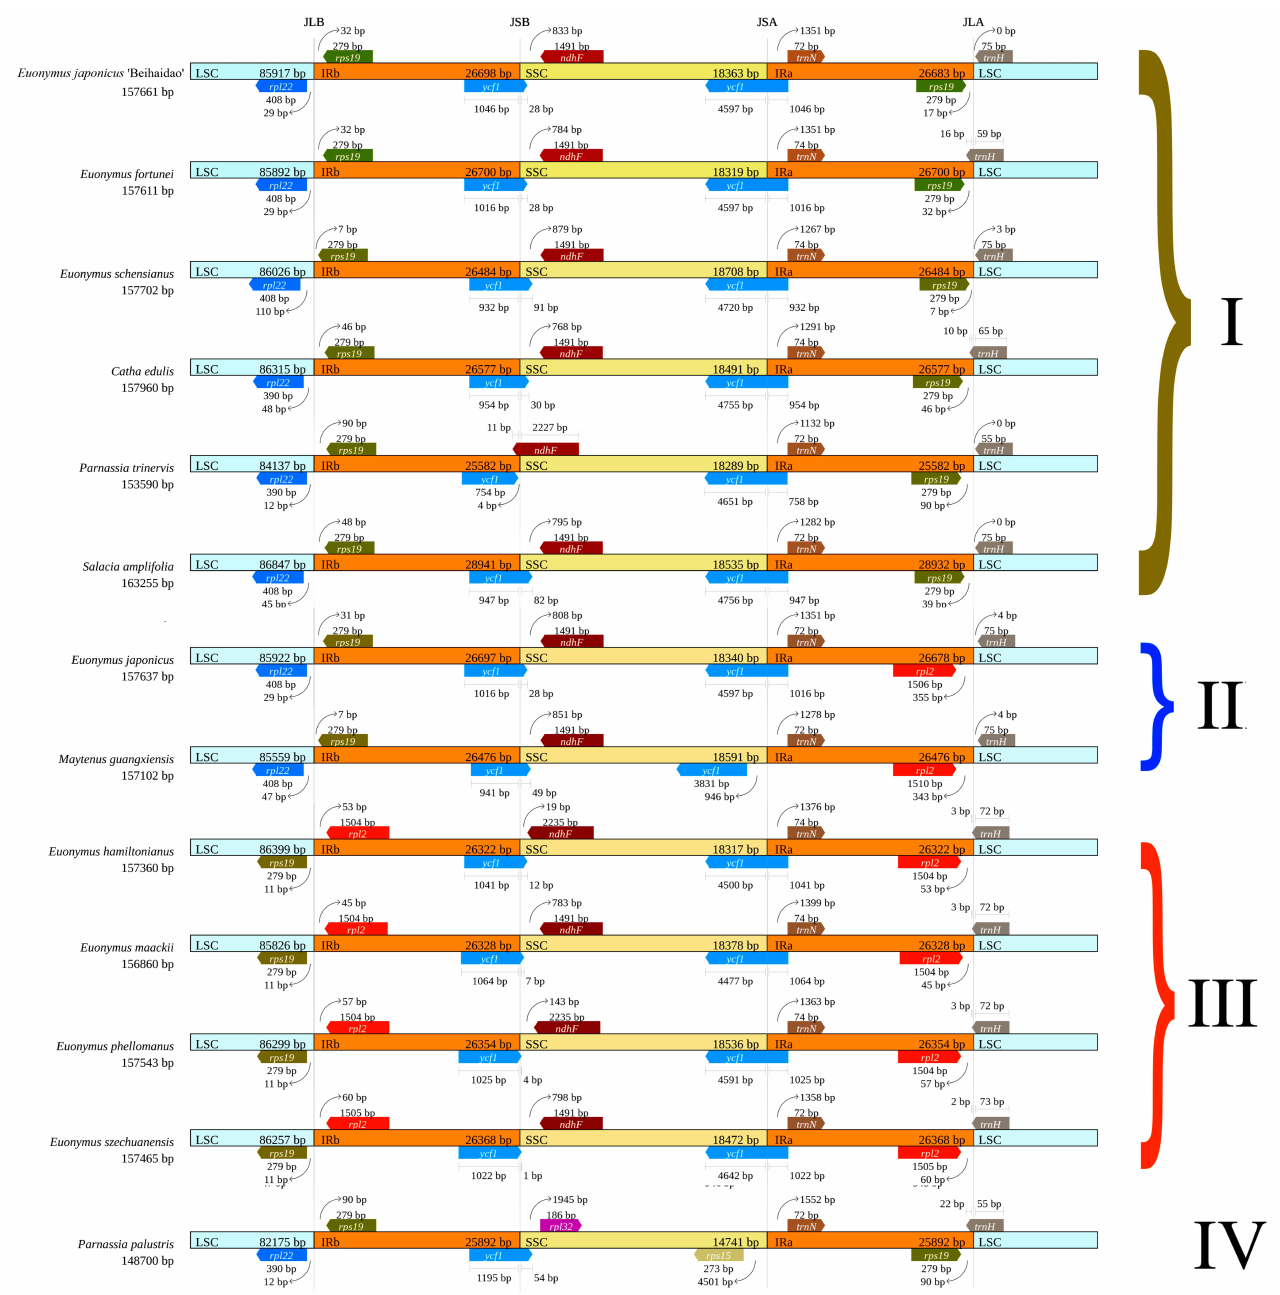
Figure 8. IR boundary figure. According to the IR boundary genes, the family Celastraceae can be divided into the following four types: type I (E. japonicus Beihaidao, E. fortunei, E. schensianus, C. edulis, M. guangxiensis, P. trinervis ), type II ( E. japonicus and M. guangxiensis ), type III ( E. hamilto-nianus, E. maackii, E. phellomanus, E. szechuanensis ), and type IV ( P. palustris